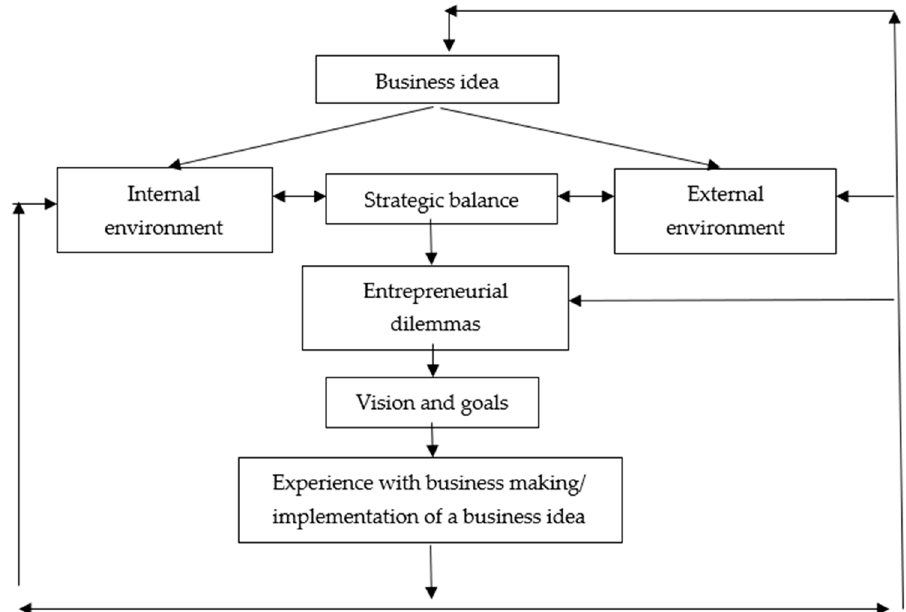
Figure 1. Strategic background of start-up as a result of research synthesis.